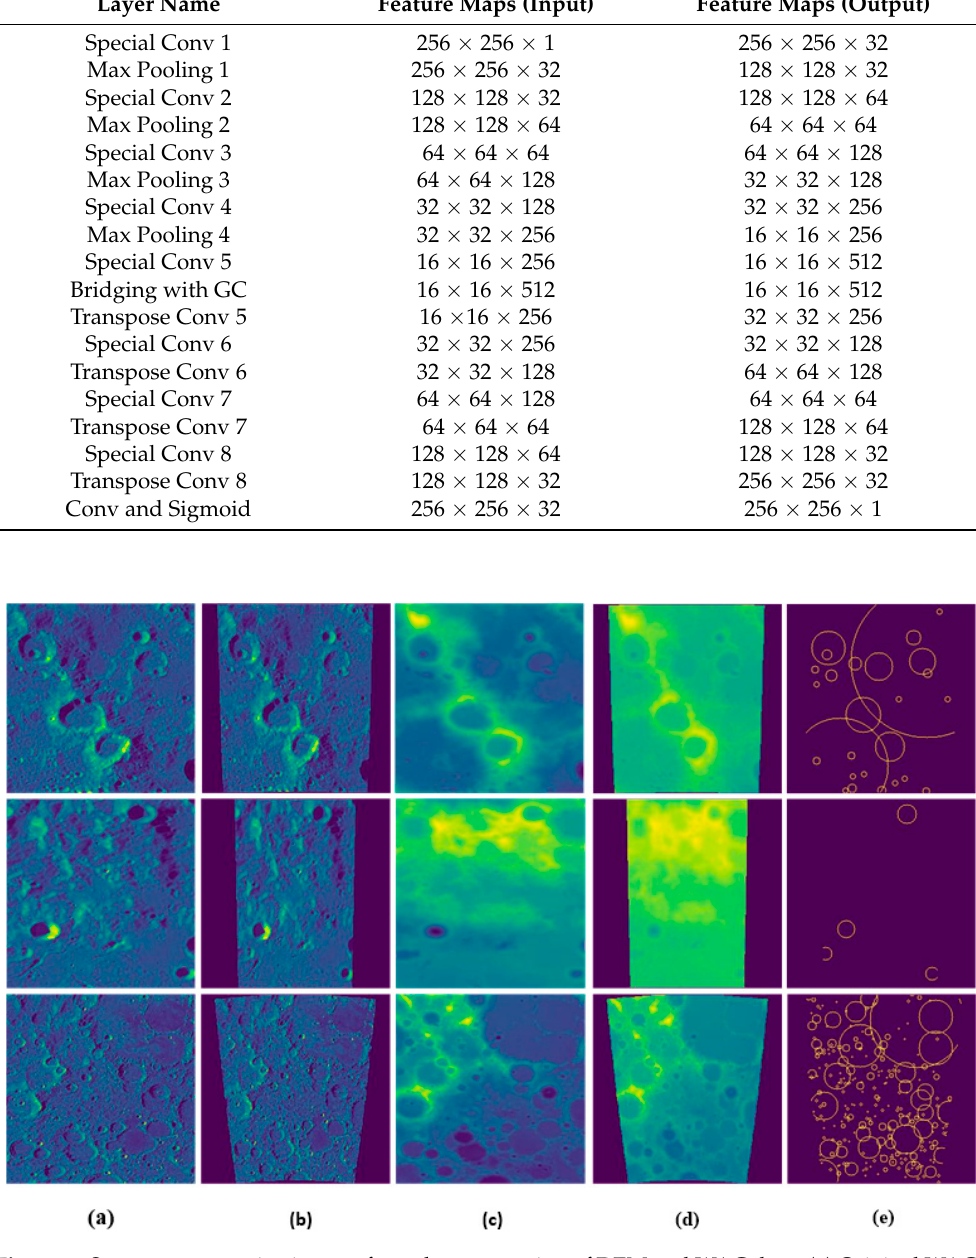
Figure 3. Some representative images from the preparation of DEM and WAC data. ( a ) Original WAC data after random cutting, ( b ) WAC after orthographic projection, ( c ) original DEM data after cutting, ( d ) DEM after orthographic projection, and ( e ) labels marked from the Povilaitis and Head datasets.